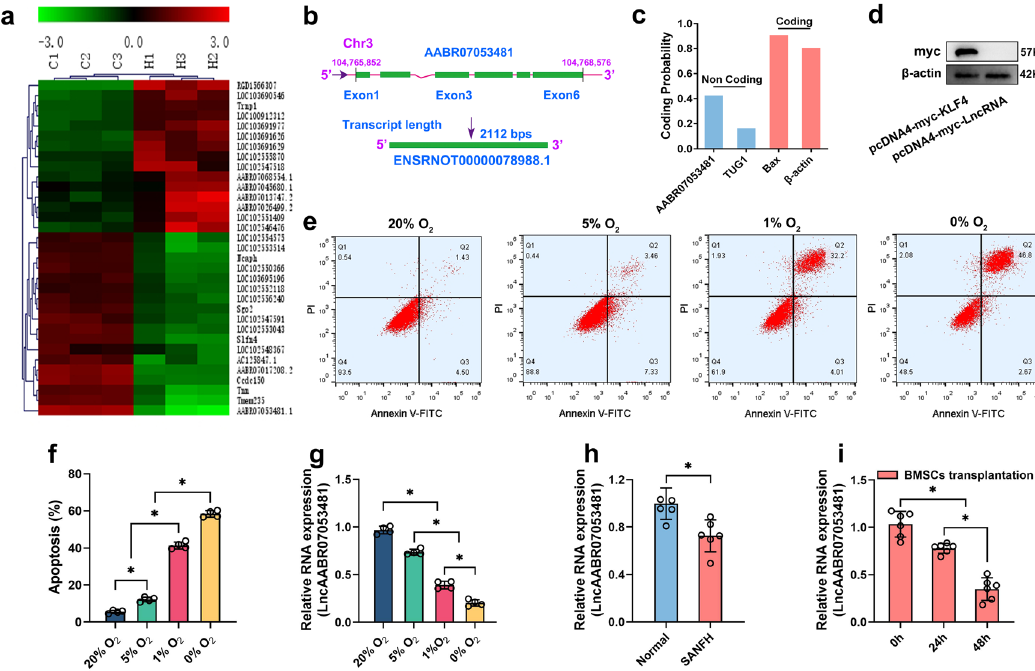
Fig. 1 LncAABR07053481 is downregulated under hypoxia and associated with apoptosis of BMSCs. a Cluster analysis of LncRNAs ( n = 3). b Location of LncRNA in the genome. c Prediction of LncAABR07053481 coding capability by the coding-potential assessment tool (CPAT). d The expression of the Myc-fused protein was analyzed by immunoblotting with an anti-Myc antibody ( n = 3). e , f The relationship between the degree of hypoxia and apoptosis ( n = 4). g Expression of LncAABR07053481 under different oxygen concentrations ( n = 4). h Detection of LncAABR07053481 expression in the normal femoral head and the area of osteonecrosis by qPCR ( n = 6). i Detection of LncAABR07053481 expression in BMSCs at different times after transplantation by qPCR ( n = 6). Data were shown as mean ± SD. * P < 0.05; In ( h ), statistical signi fi cance was calculated by Student ’ s t -test; in ( f , g , i ), statistical signi fi cance was calculated by one-way ANOVA with Tukey ’ s post hoc